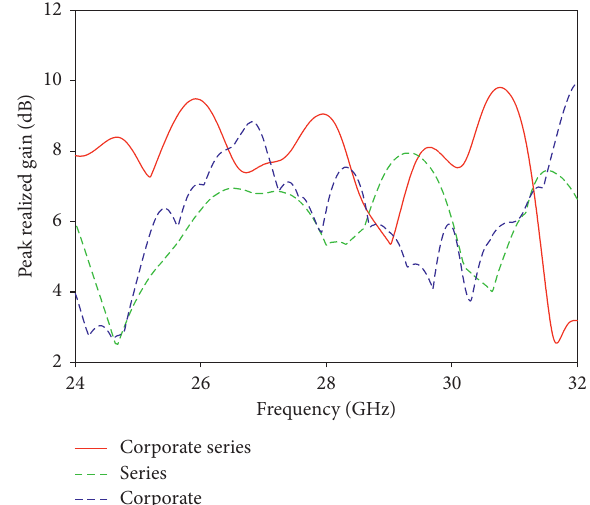
Figure 13: Peak realized gain of proposed microstrip array antenna with corporate-series, series-, and corporate